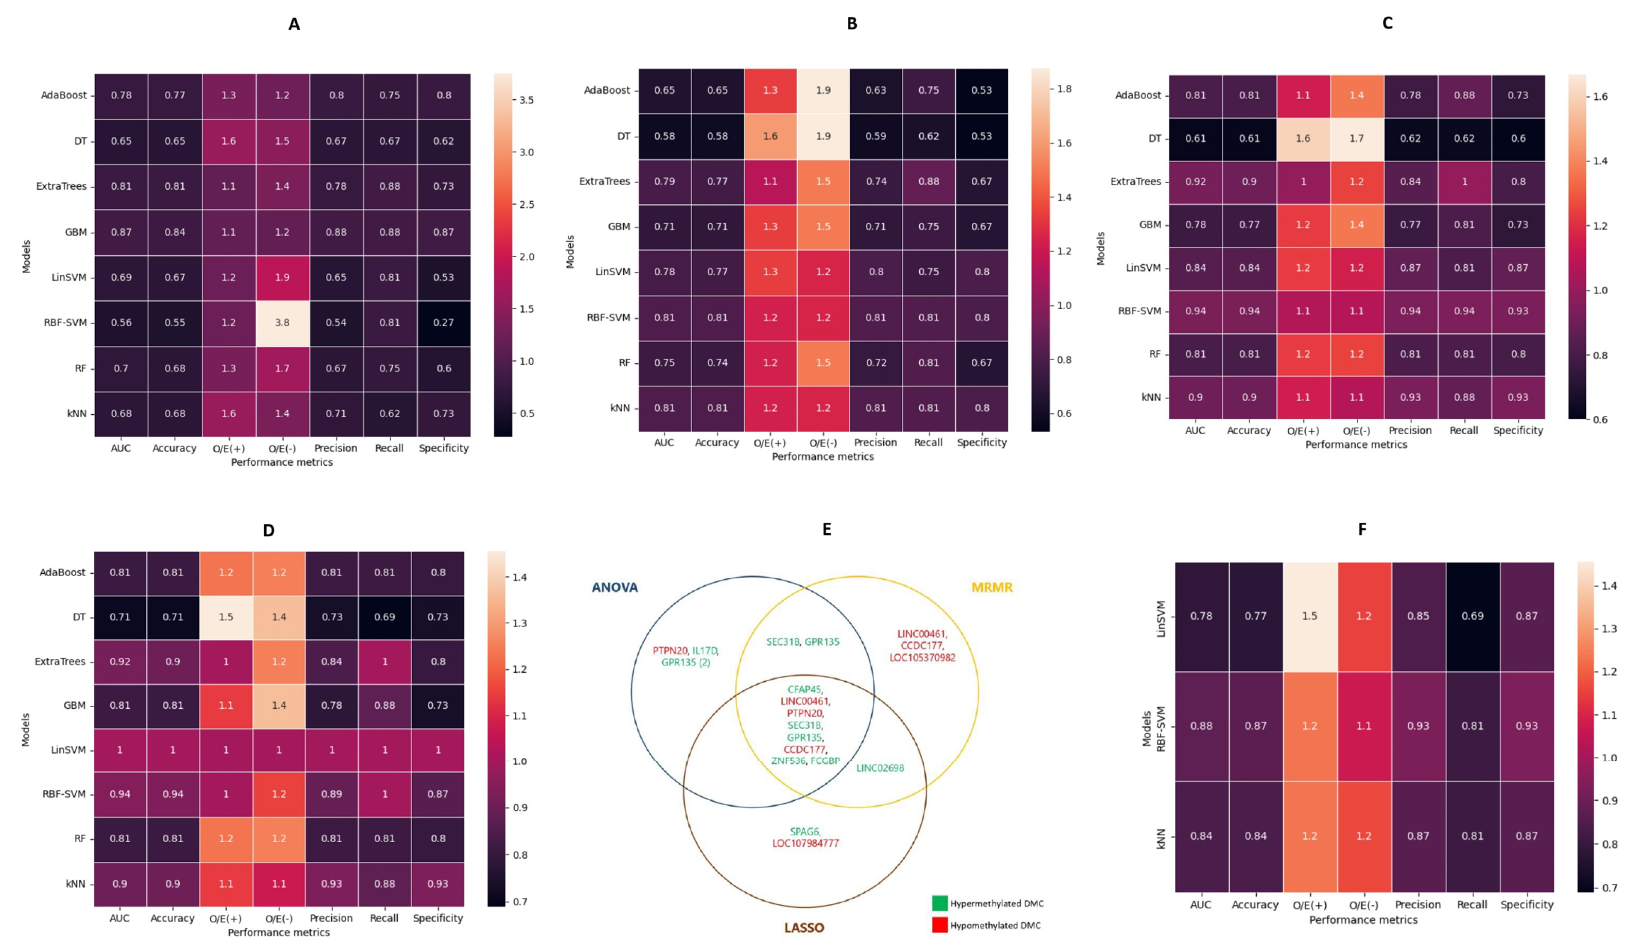
Figure 5. Performance of machine learning models for predicting OSCC using DMRs as features. ( A ) Initial models comprising all 105 DMRs. ( B ) Machine learning models based on ANOVA-selected DMR sets for predicting OSCC. ( C ) Machine learning models based on MRMR-selected DMR sets for predicting OSCC. ( D ) Machine learning models based on LASSO-selected DMR sets for predicting OSCC. ( E ) Selected DMR features by the three feature-selection methods and their concordance. ( F ) Machine learning models based on eight consensual DMRs for predicting OSCC.